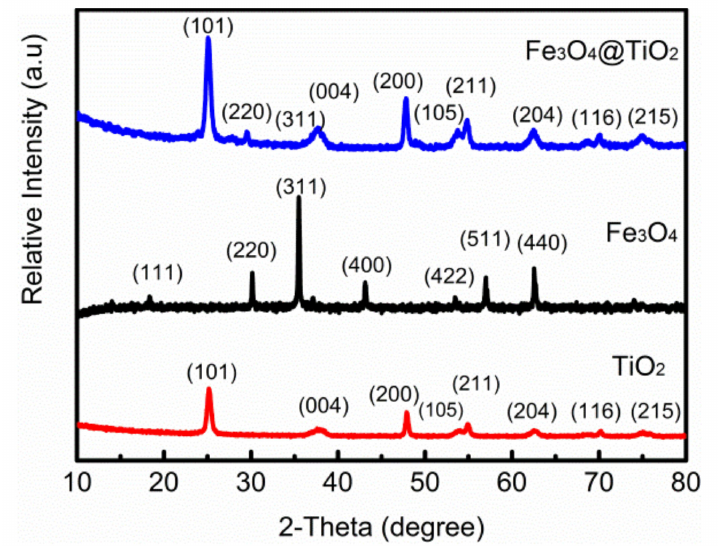
Figure 1. XRD patterns of TiO 2 , Fe 3 O 4 and Fe 3 O 4 @TiO 2